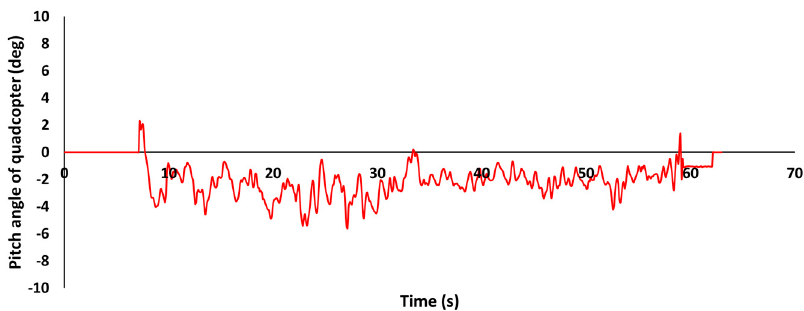
Figure 33. Pitch angle of the quadcopter during the vertical takeoff and landing .